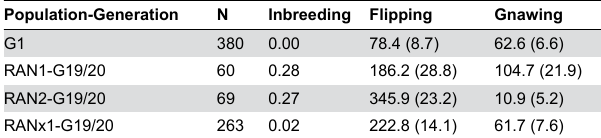
Table 6. Mean inbreeding and activity scores (SE) for mice in the starting population (G1), final two generations of each experimental population (RAN1, RAN2, MK1, and MK2), and two generations of intercrosses between replicates of each protocol (RANx1, RANx2, MKx1, and MKx2).